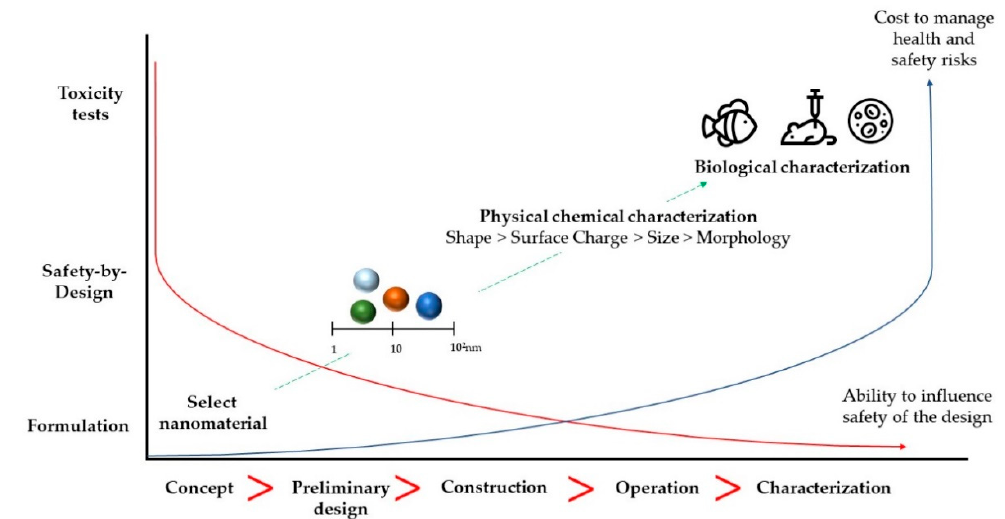
Figure 3. Relevant properties of nanomaterials in view of their safety assessment and the influence over a product’s